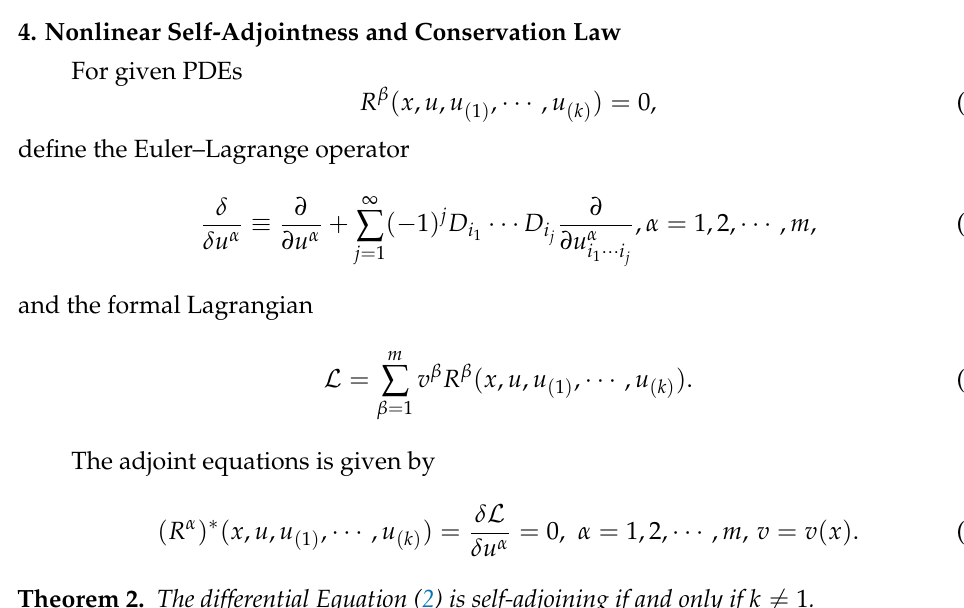
Figure 6. The graph of u ( x , t ) given by Equations (25) and (26) for k =